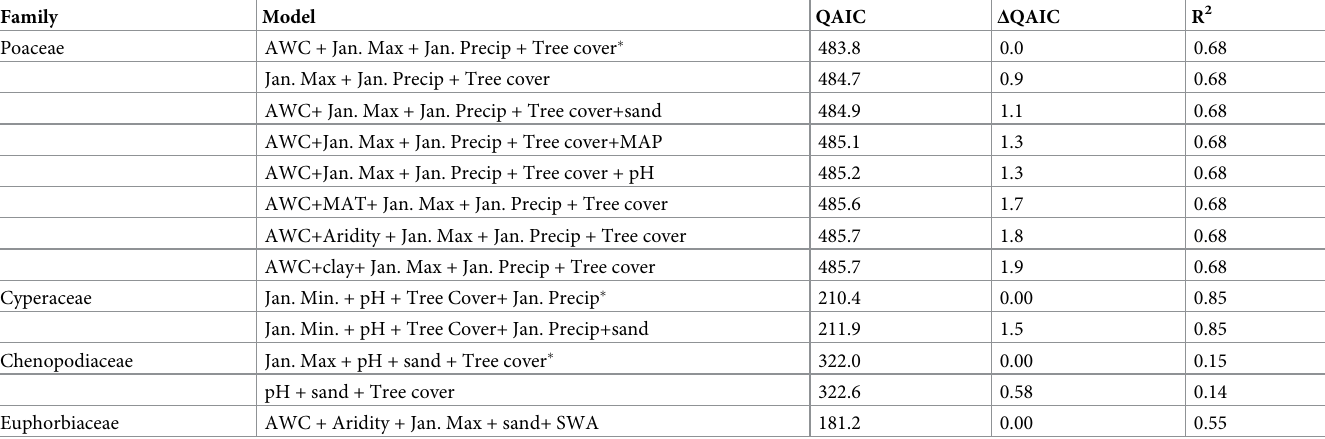
Table 2. Logistic regression model results of proportional C 4 cover for Poaceae, Cyperaceae, Chenopodiaceae, and Euphorbiaceae.